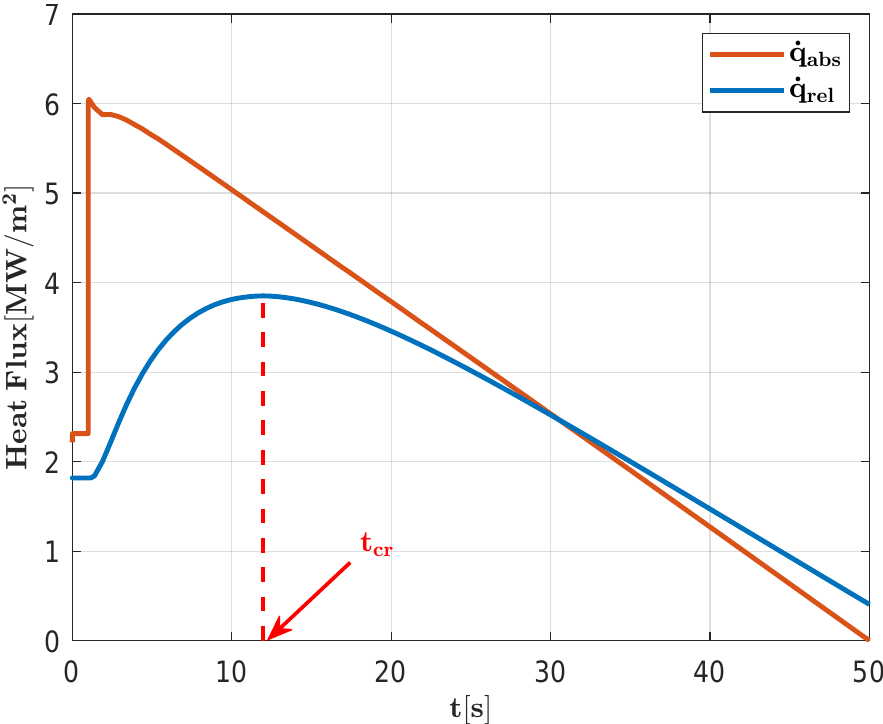
Figure 4. Comparison between the trend of the thermal flux disposed through a node belonging to the pipe wall, ˙ q rel , and the thermal flux absorbed by a node on the top of the armour, ˙ q abs , during the ramp-down phase (with respect to the second optimised configuration). t cr is the time at which the thermal flux disposed of by the cooling pipe was the